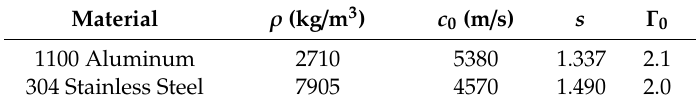
Table 4. M–G eos parameters [31,45], with permission from Elsevier,